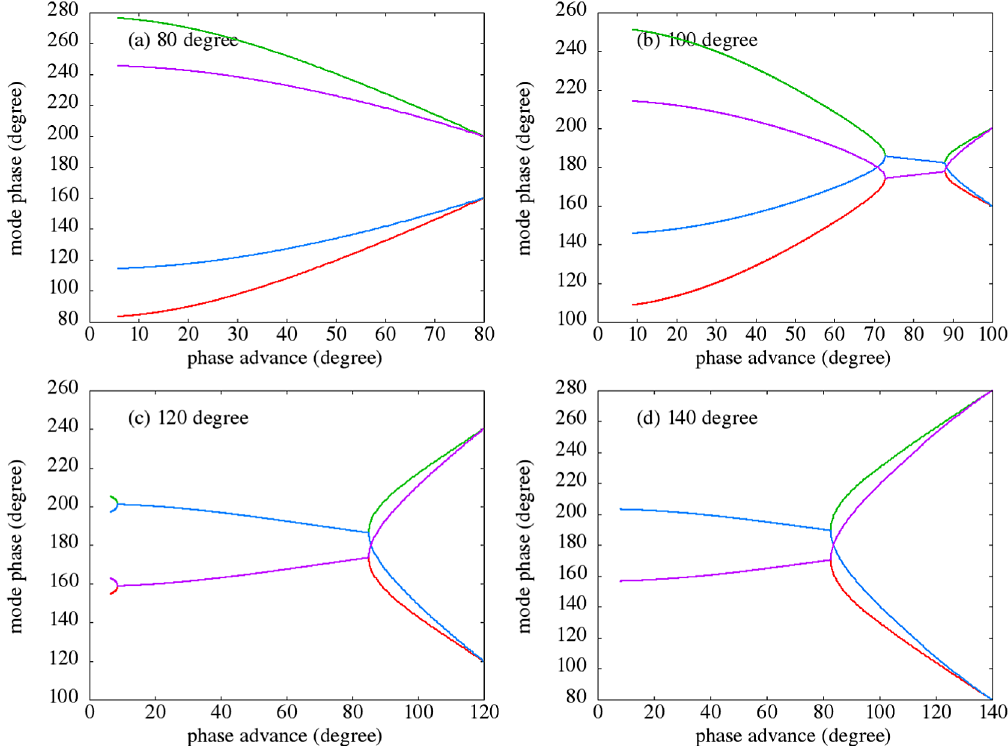
FIG. 11. The 2D envelope mode phases as a function of depressed transverse phase advance for (a) 80 °, (b) 100 °, (c) 120 °, and (d) 140 ° zero current transverse phase advances in a periodic quadrupole channel. The four colors are the phases of the four eigenvalues.